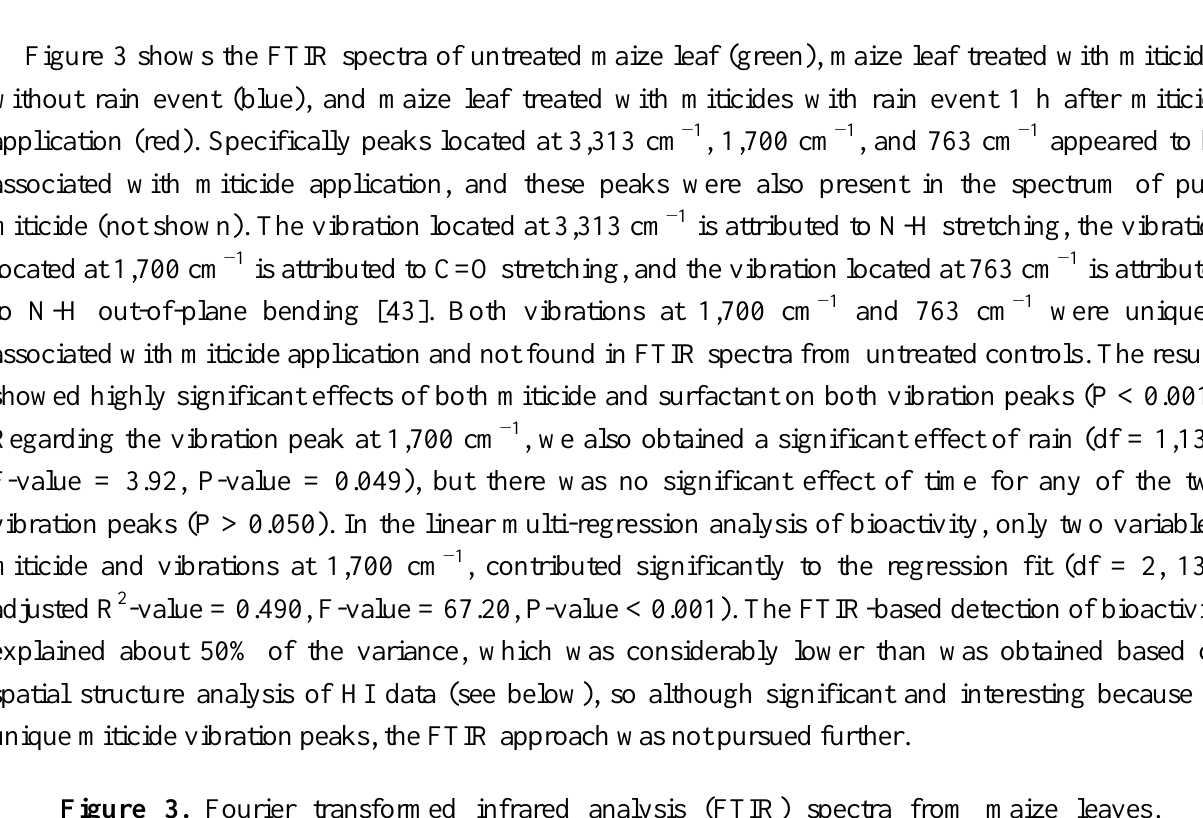
Figure 3. Fourier transformed infrared analysis (FTIR) spectra from maize leaves. Untreated control maize leaf (in green), maize leaf treated with miticide before rain